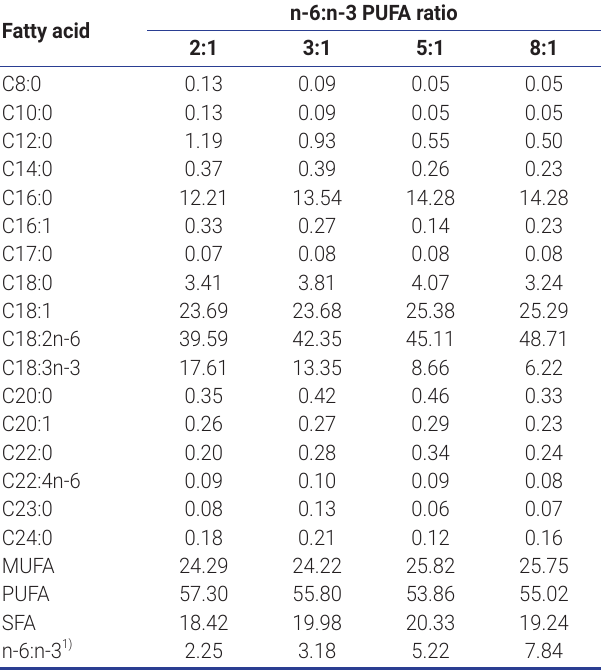
Table 2. Fatty acid composition of the experimental diets (% total fatty